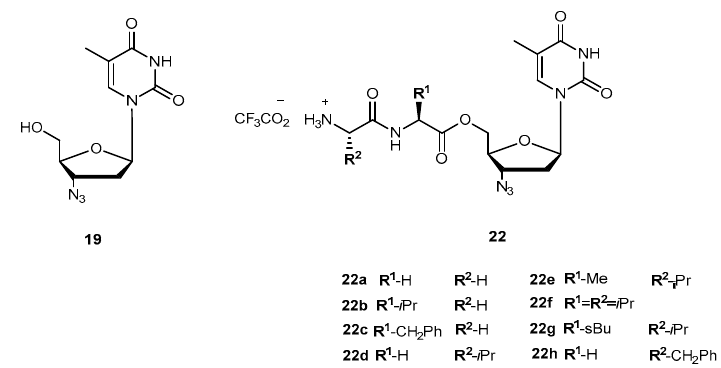
Figure 10. Structure of 19 and its dipeptide prodrugs 22a – h.